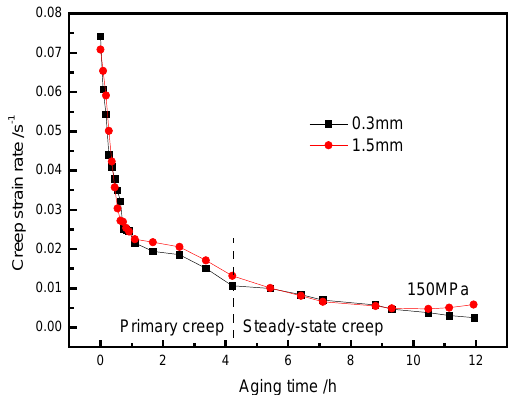
Figure 4. The comparisons of creep strain rates curves between 0.3 mm and 1.5 mm AA2024 at 453 K under stress of 150 MPa.